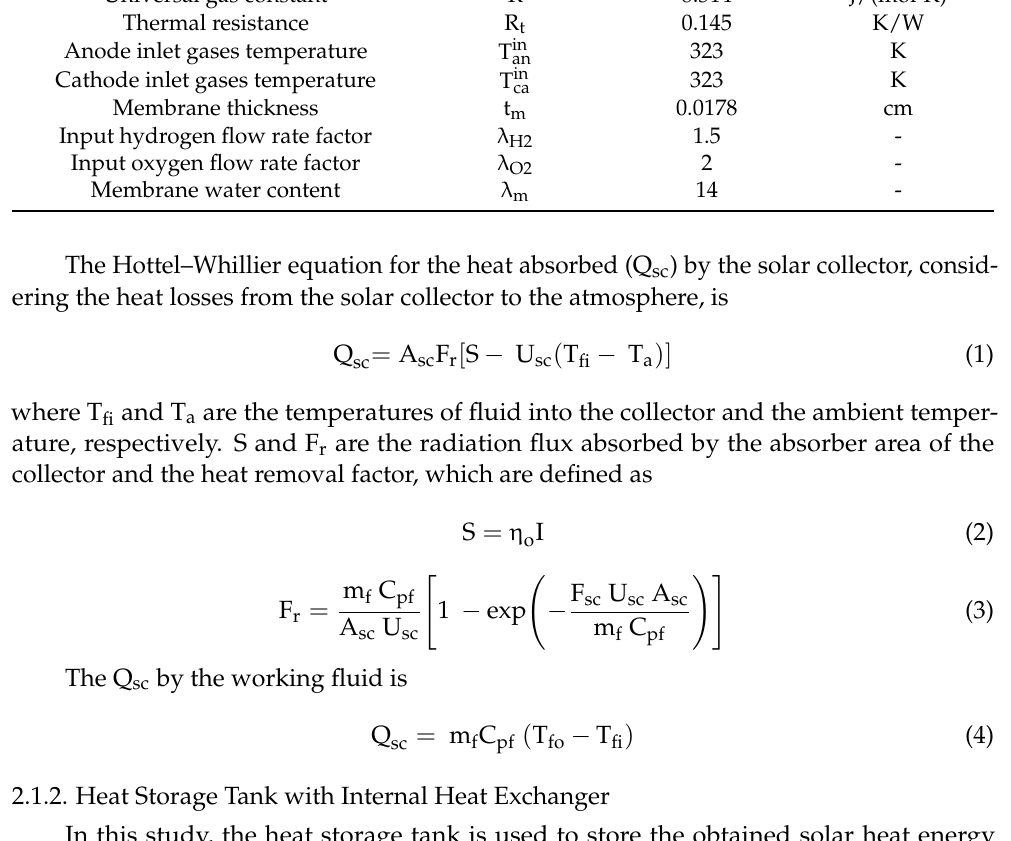
Table 1. Cont. Parameter Description Symbol Value Unit Universal gas constant R 8.314 J/(mol · K) Thermal resistance R t 0.145 K/W Anode inlet gases temperature T in an 323 K Cathode inlet gases temperature T in ca 323 Membrane